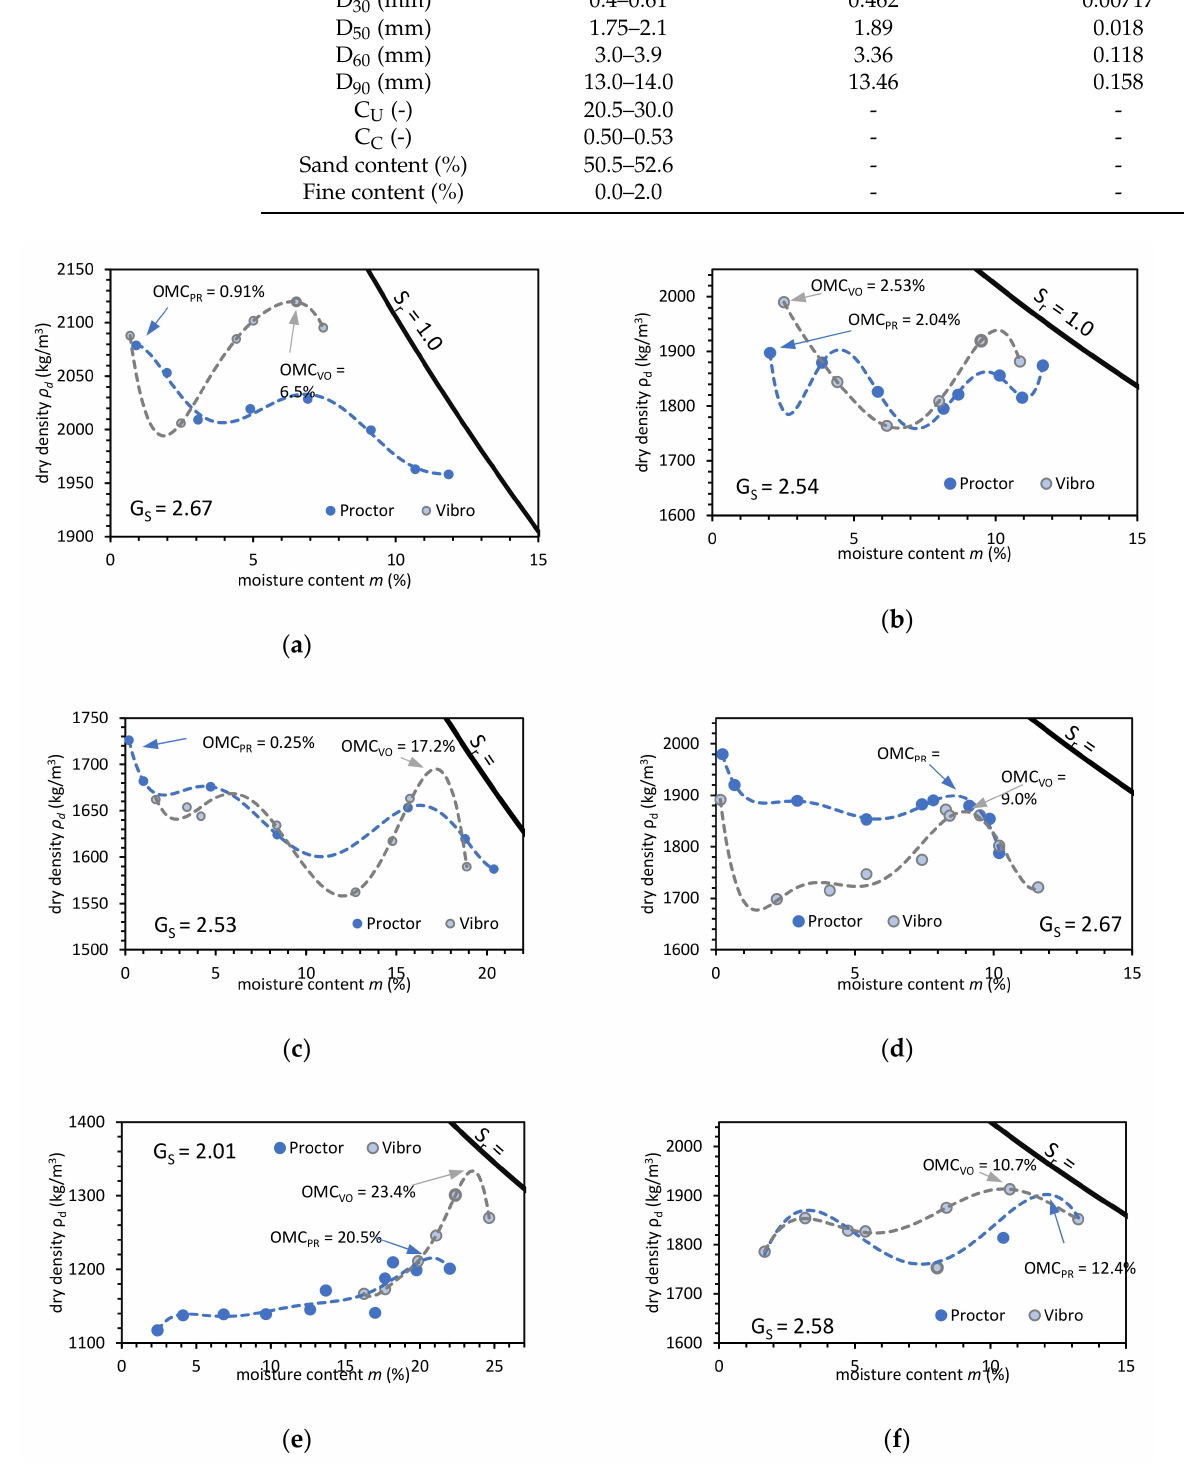
Figure 2. Compaction characteristics as a function of soil dry density versus moisture content of natural aggregate: ( a ); construction and demolition materials: ( b ); RCA; ( c ) CB; ( d ) RAP, and industrial solid wastes; ( e ) FA + BS; ( f ) BFS. S r = 1.0 indicates full saturation conditions, G S indicates specific